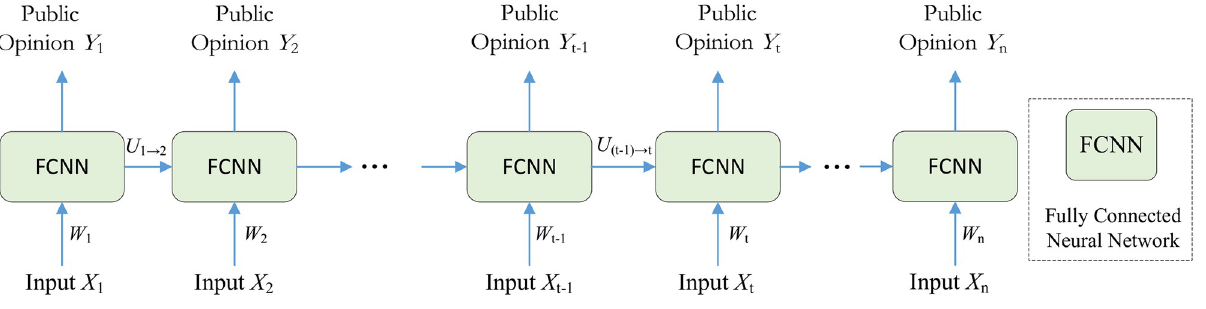
Fig 3. Construction of cyclic, fully connected neural network